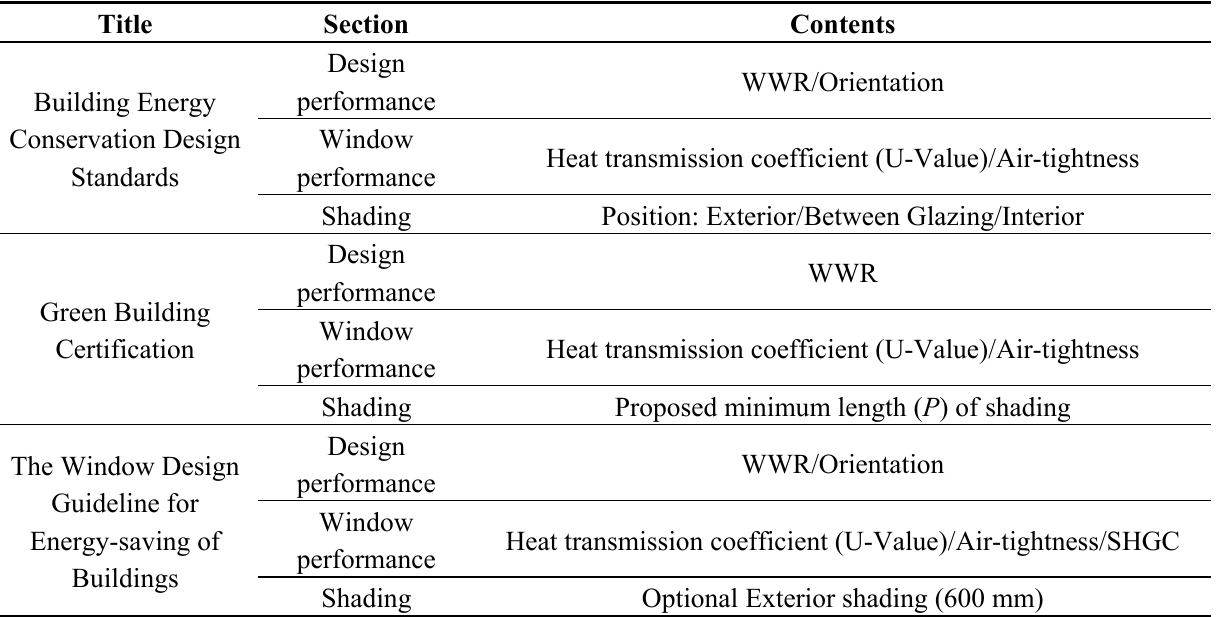
Table 1. Regulation and guidelines for windows in